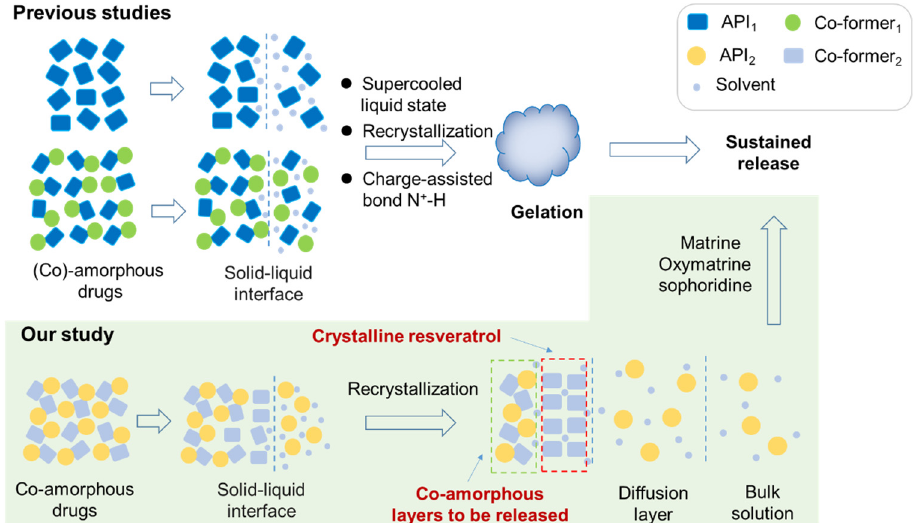
Figure 6. The proposed sustained-release mechanism for co-amorphous matrine/oxymatrine/sophoridine and resveratrol, in comparison to previously reported gelation-based release mechanism.